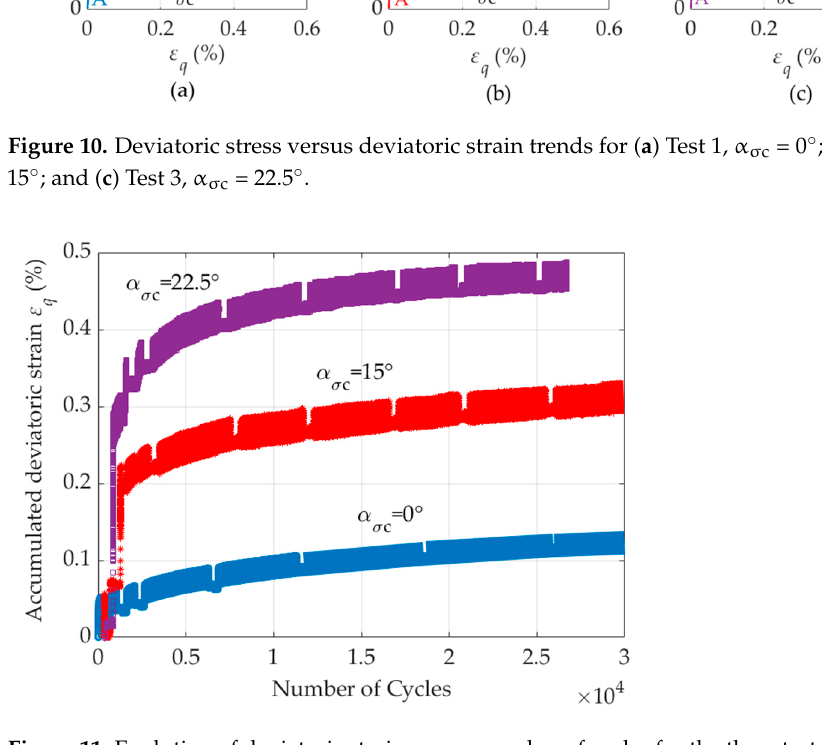
Figure 11. Evolution of deviatoric strain versus number of cycles for the three tests.